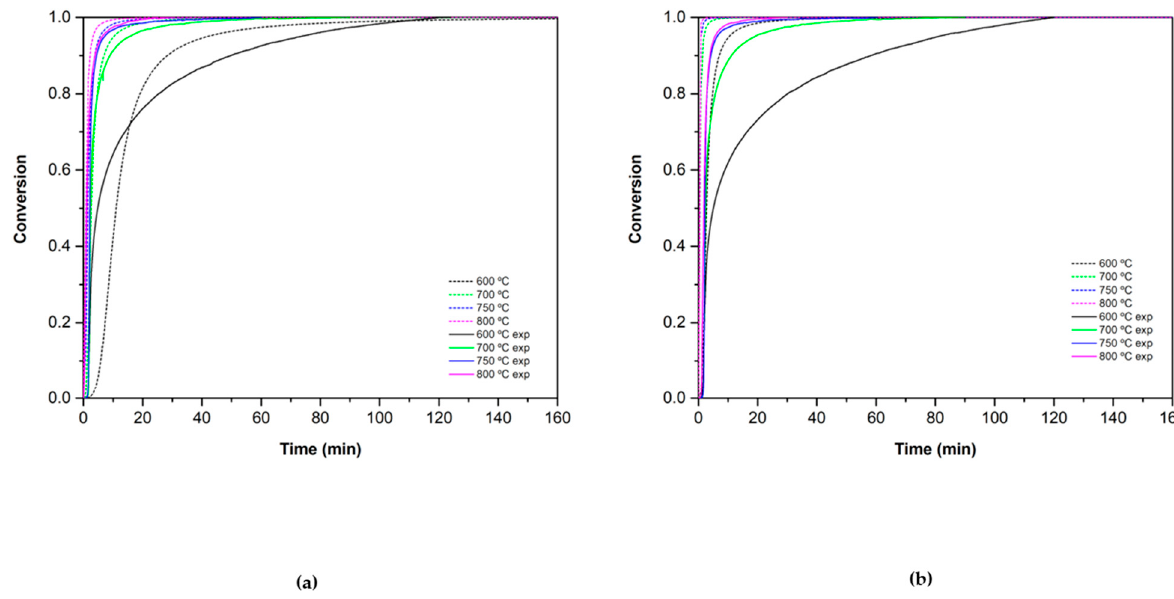
Figure 11. Oxidation conversion validation for ( a ) Co 2.4 Ni 0.6 O 4 and ( b ) 0.5% SiO 2 / Co 2.4 Ni 0.6 O 4 . The dotted lines correspond to the theoretical values and the solid ones to the experimental ones.